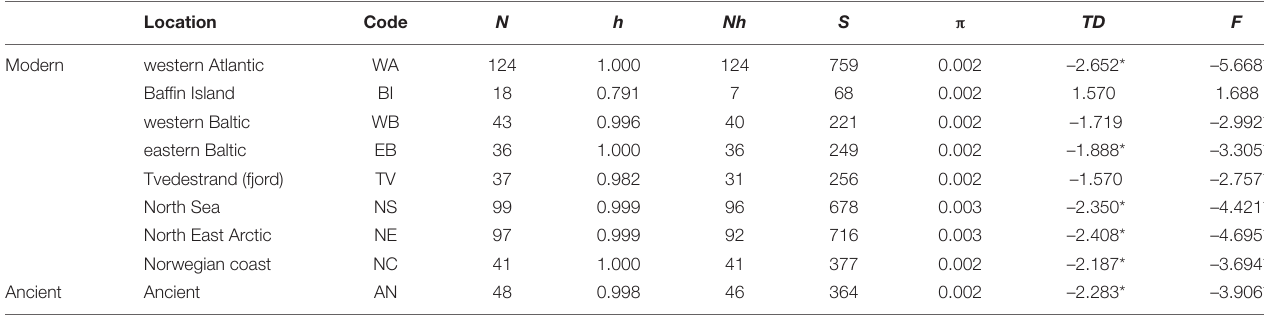
TABLE 1 | Estimates of genetic diversity statistics for Atlantic cod at whole mitogenomes from different marine locations or ecotypes in the North Atlantic (see Supplementary Tables 1, 2, 5 ). Location